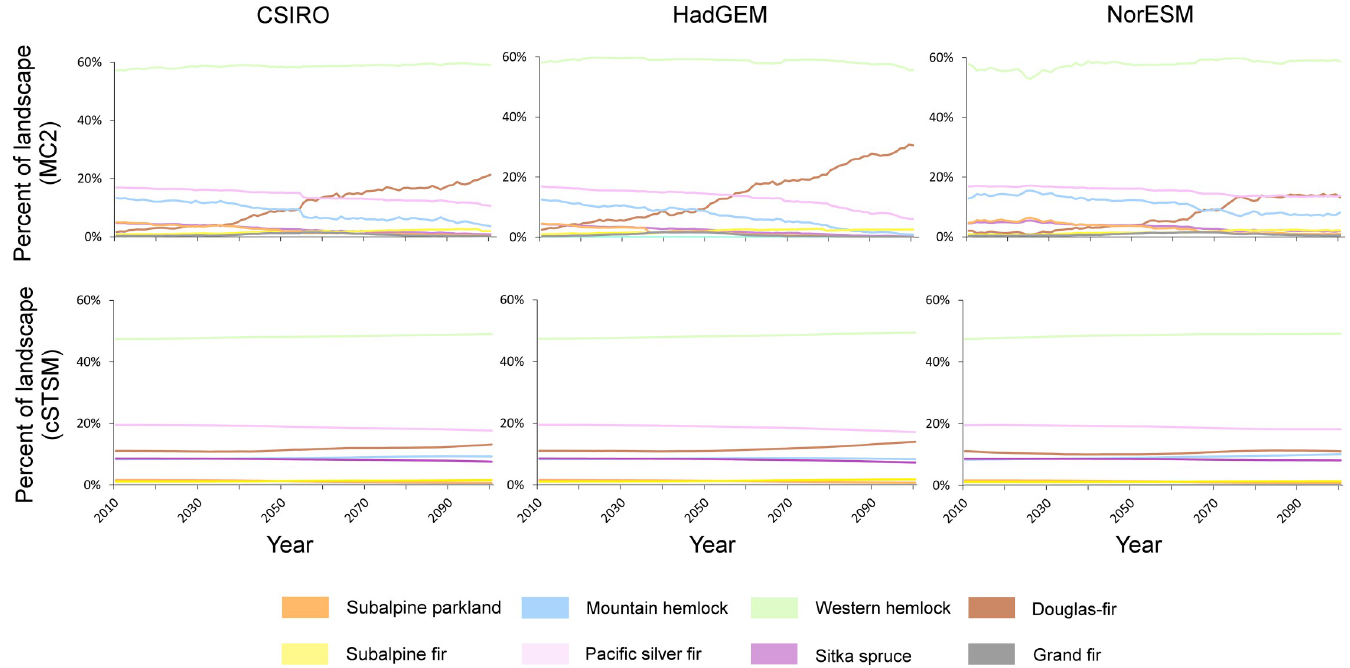
Fig 6. Projected MC2 (top row) and average cSTSM (bottom row) forest zone trends. Differences between MC2 and cSTSM trends reflect differing assumptions of landscape inertia: MC2 shows incremental change in potential distribution without accounting for inertia effects, while cSTSM only allows actual change to occur after high-severity